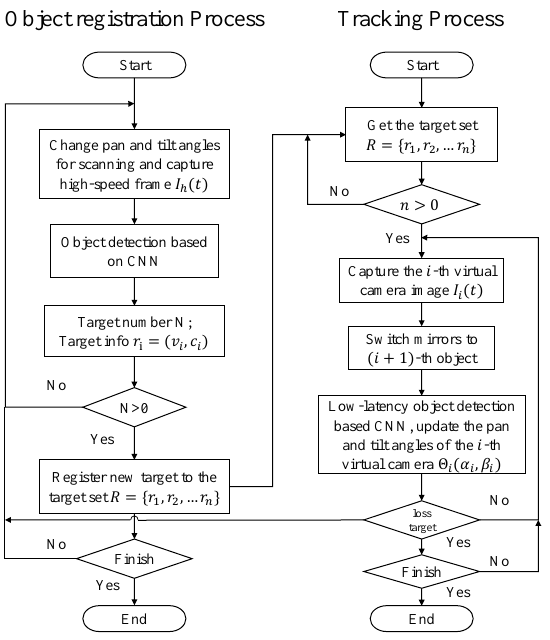
Figure 3. Flowchart of object registration process and multi-object tracking